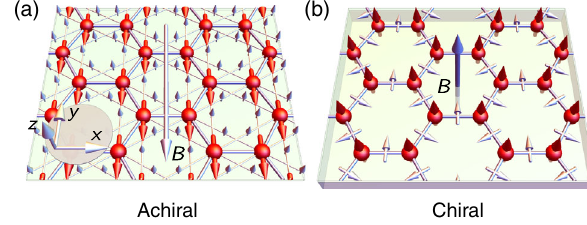
FIG. 1. Honeycomb-lattice ferromagnets with DMI, which are minimal models to realize nonconserved interacting Dirac mag- nons. Red arrows depict field-polarized spin moments, small arrows at the bonds indicate DMI vectors, and the large arrow shows the direction of the magnetic field. (a) Achiral in-plane magnetized ferromagnet with second-nearest-neighbor DMI. (b) Chiral ferromagnet with interfacial DMI due to structural inversion asymmetry, as indicated by a substrate layer. The texture is out-of-plane field